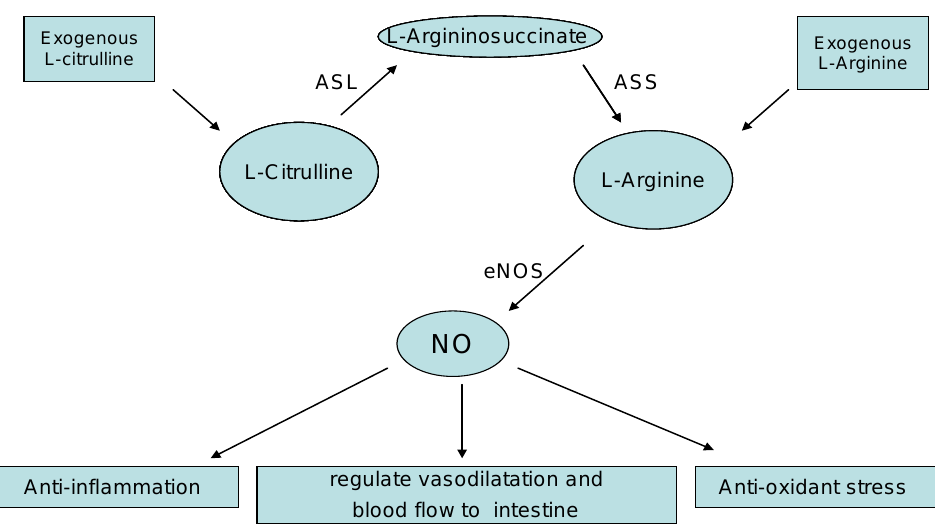
Figure 2. Possible mechanisms involved in the pathogenesis of Necrotizing enterocolitis (NEC). ASS, argininosuccinate synthase; ASL, argininosuccinate lyase; NO, nitric oxide; NOS, nitric oxide synthase.